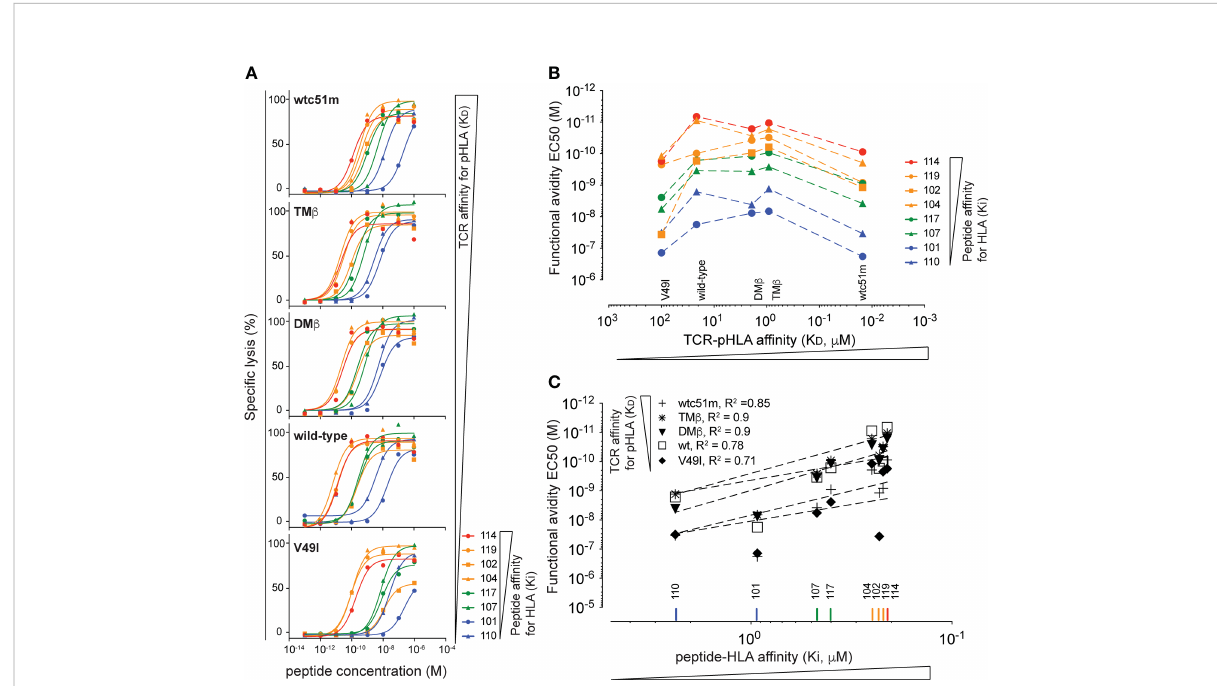
FIGURE 4 Hierarchical analysis of TCR-pHLA K D af fi nity versus peptide:HLA K i af fi nity. (A) Curves obtained from parallel cytotoxic killing assays of primary CD8 T cells expressing fi ve NY-ESO-1 157-165 -speci fi c TCRs of incremental af fi nities (very low af fi nity K D of V49I < 100 m M, wild type K D = 21.4 m M, optimized DM b = 1.91 m M and TM b = 0.91 m M and very high af fi nity TCR wtc51 = 0.015 m M) against 8 NY-ESO-1 157-165 peptide variants of increasing (n = 4 to 8). (B) Functional avidity values (EC 50 ) obtained from the parallel killing assays of the NY-ESO-1 157-165 -speci fi c T cells plotted against the K D af fi nity of the TCR for the pHLA. (C) Correlation analysis between the functional avidity values (EC 50 ) of the NY-ESO-1 157-165 - speci fi c T cells and the K i af fi nity of the respective target peptides. R square values are